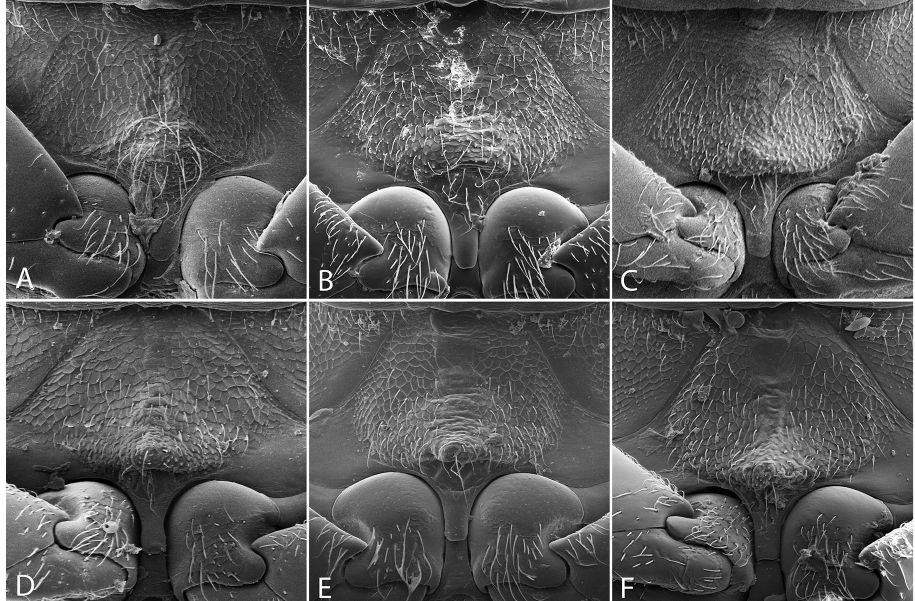
Figure 9. Mesoventrite of Tobochares spp. A T. canthus sp. n. B T. canaliculatus sp. n. C T. pallidus sp. n. D T. kasikasima E T. sipaliwini F T. striatus